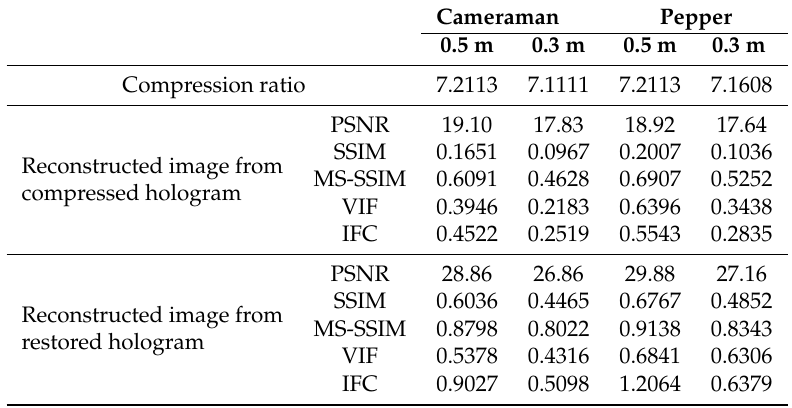
Table 1. PSNR (dB), SSIM, MS-SSIM, VIF and IFC values of reconstructed results from JPEG compressed holograms and restored holograms with our proposed